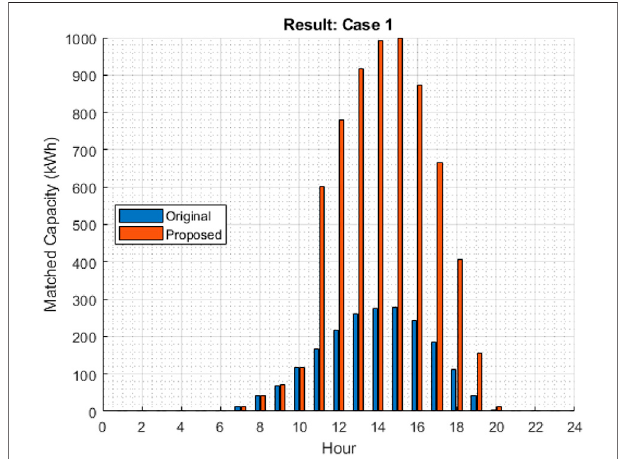
FIGURE 5 | Matched capacity results comparison from Case 1.